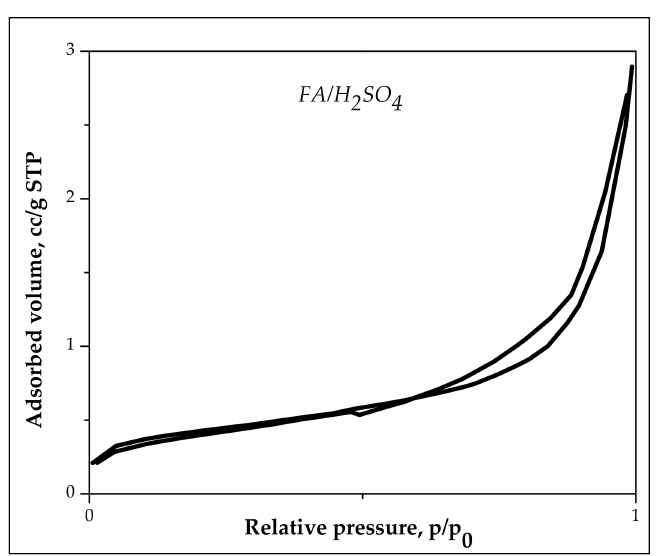
Figure 5. Nitrogen adsorption isotherm at 77 K on FA / H 2 SO 4